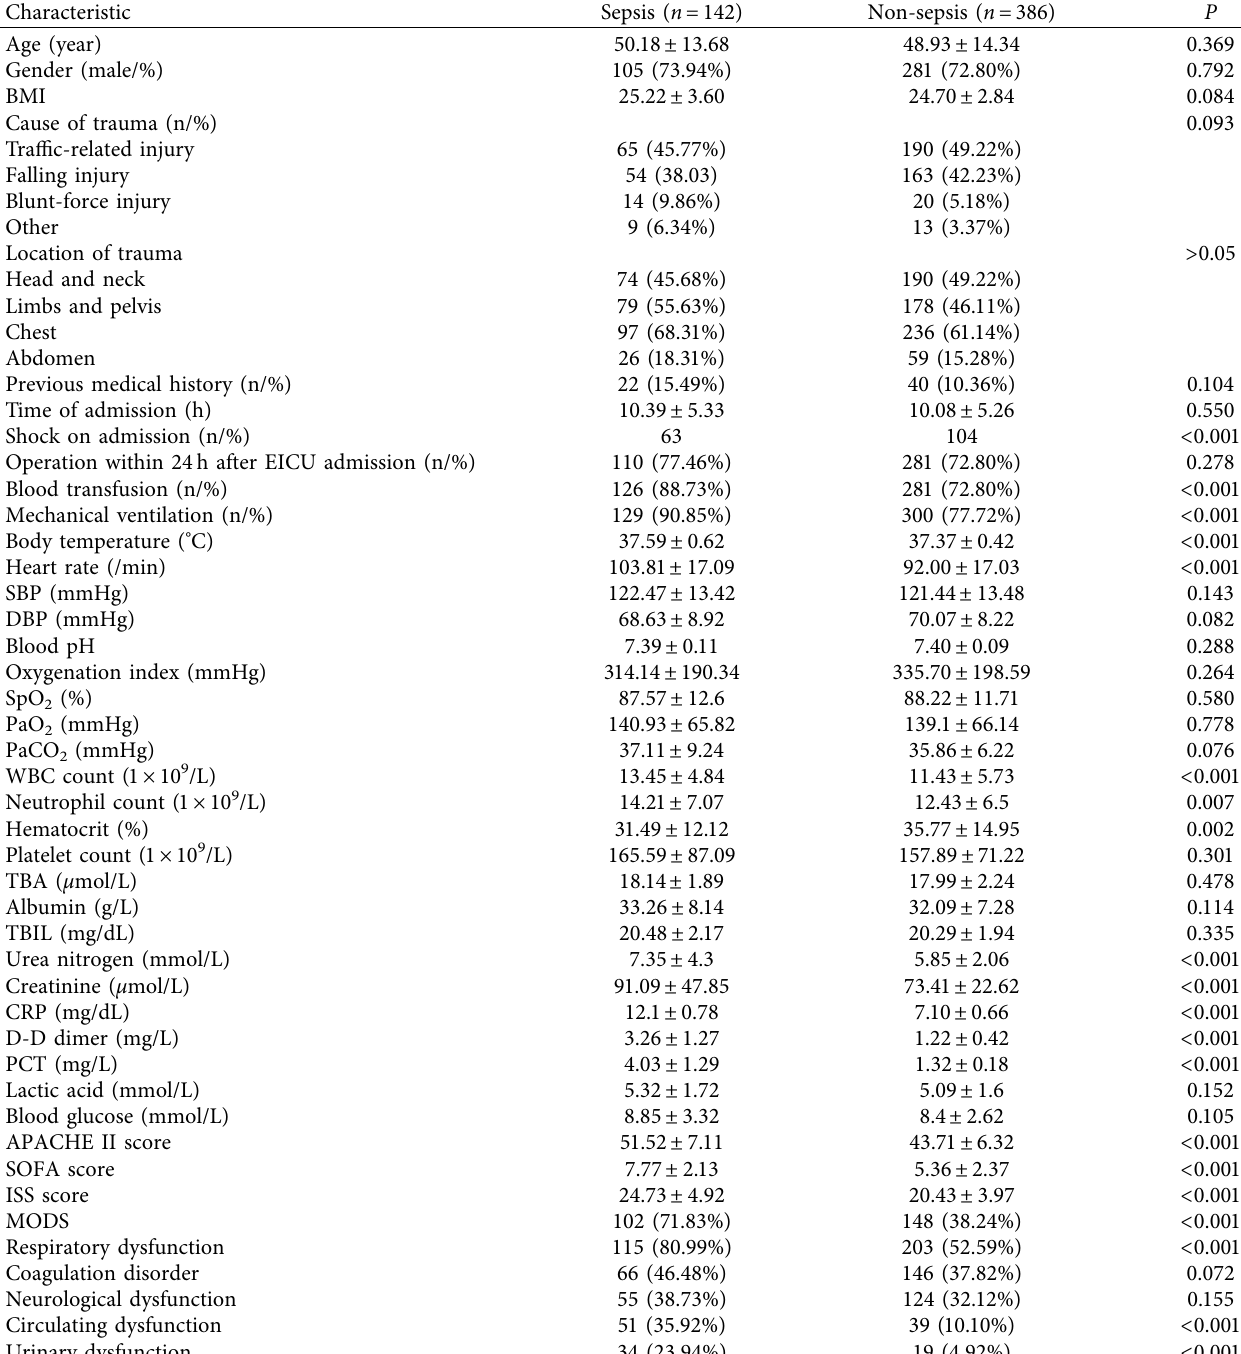
Table 2: Patient characteristics between sepsis and non-sepsis